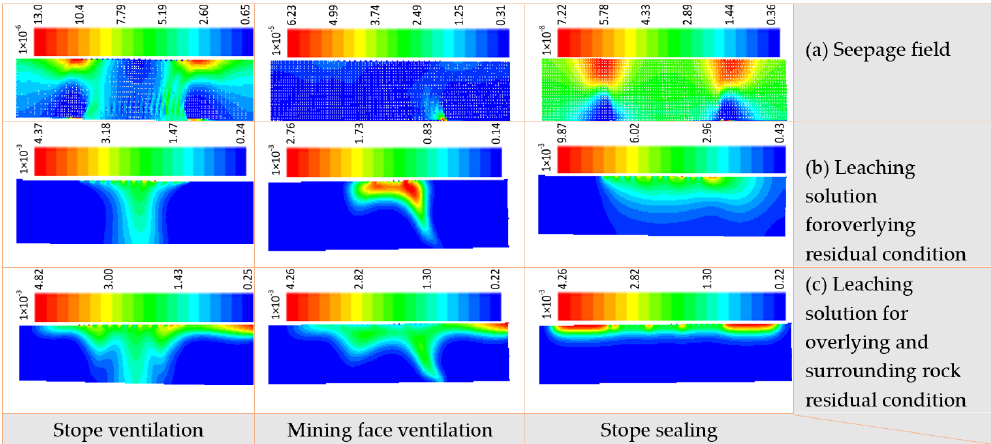
Figure 6. Multifield coupling evolution in the mining of uranium prior to coal. ( a ) Seepage field; ( b ) Leaching solution for the overlying residual condition; ( c ) Leaching solution for the overlying and surrounding rock residual conditions.